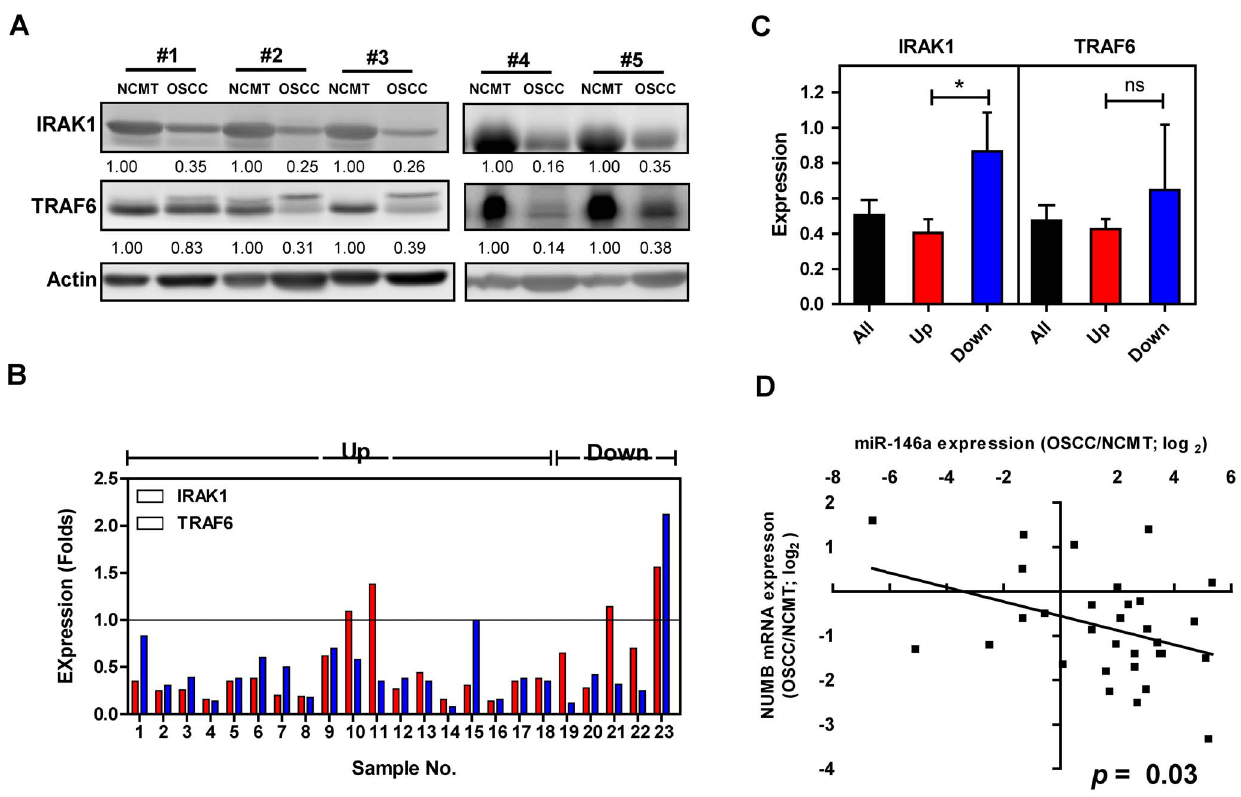
Figure 12. Reverse association between miR-146a expression and NUMB mRNA expression in OSCC tissues. (A) Western blot analysis for IRAK1 and TRAF6 expression in OSCC and NCMT tissue pairs. Numbers depict the normalized values. (B) Expression of IRAK1 and TRAF6 revealed by the ratio of OSCC/NCMT in 23 OSCC tissue pairs. The vast majority of OSCC exhibits the decreased IRAK1 and TRAF6 expression. Samples 1–18 have miR-146a up-regulation, while samples 19–23 have miR-146a down-regulation. (C) Expression of IRAK1 and TRAF6 in relation to miR-146a expression status. OSCC tissues having miR-146a up-regulation exhibit a significantly lower IRAK1 expression. The decrease of TRAF6 expression is not significant in OSCC having miR-146a up-regulation. Up, samples having miR-146a up-regulation; Down, samples having miR-146a down-regulation. Data shown are means 6 SE (in C). ns , not significant; *, p , 0.05; Mann-Whitney test. (D) Linear regression analysis of miR-146a expression in relation to NUMB mRNA expression in 31 OSCC tissue pairs. X-axis: miR-146a expression revealed by log 2 transformation. Y-axis: NUMB mRNA expression revealed by log 2 transformation. Line, regression line. A reverse association between miR-146a expression and NUMB mRNA expression in OSCC tissues is noted.